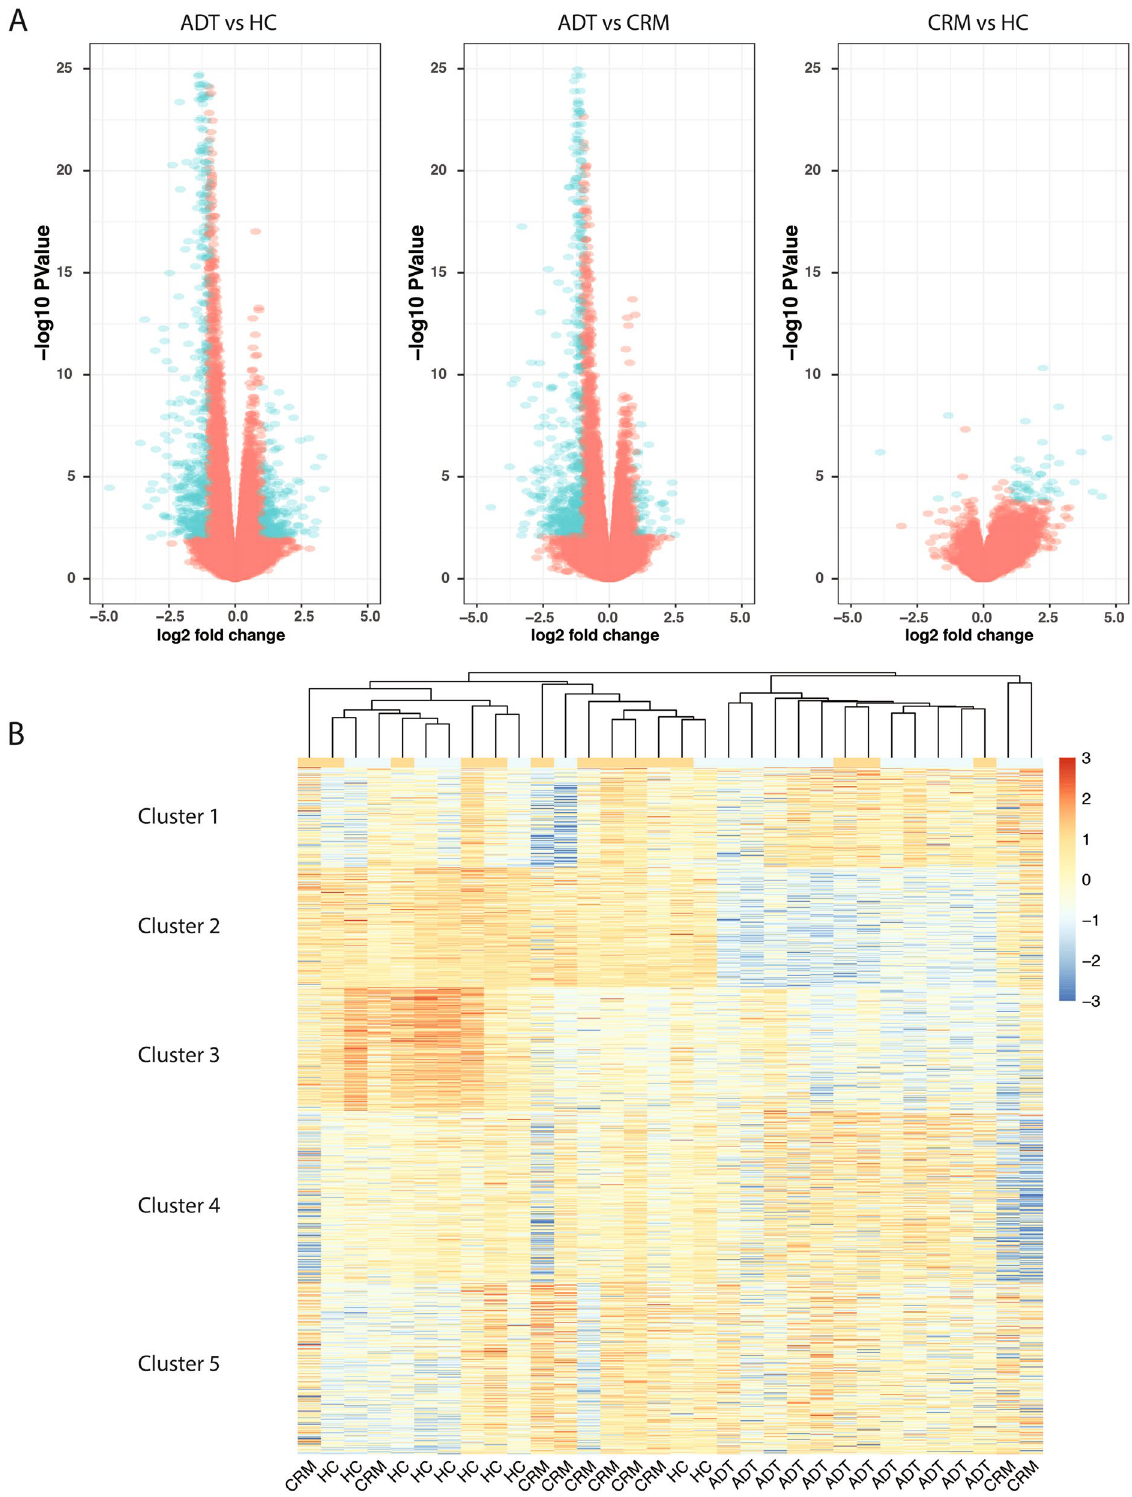
Figure 1. Attainment of clinical remission in JIA normalizes gene expression in CD4+ T-cells. ( A) Volcano plots for each of the pairwise comparisons of gene expression between groups. ( B ) Heatmap showing the expression of all genes that were considered differentially expressed between any two groups. Kmeans clustering was applied to separate genes into one of 5 clusters and hierarchal clustering was applied to cluster the